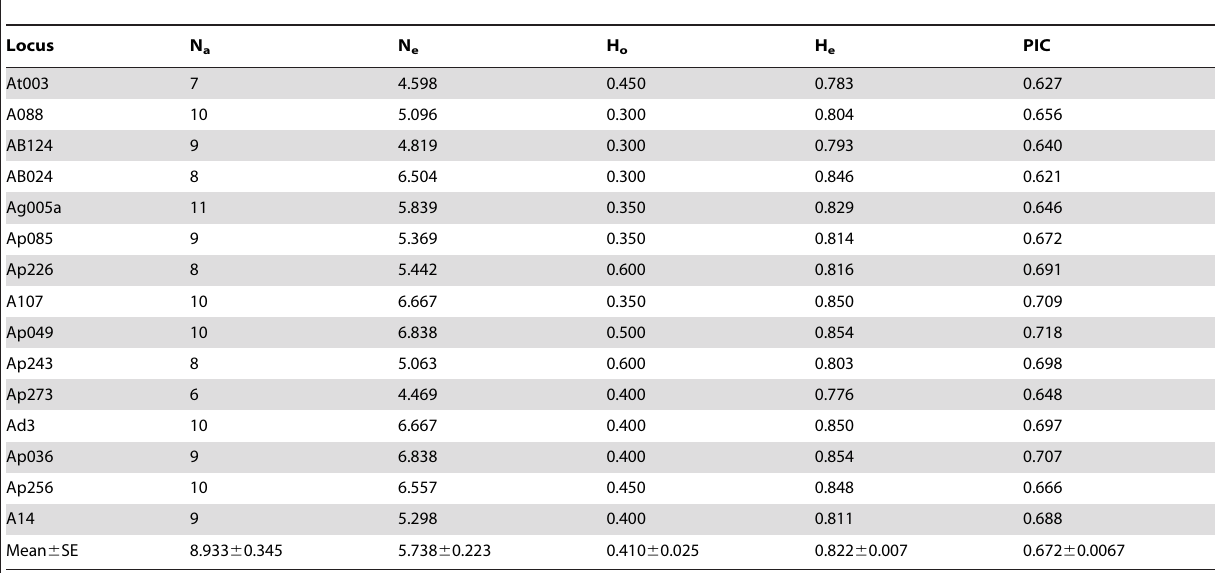
Table 3. A summary of microsatellite genetic variation in the low solitary nests of A. dorsata .